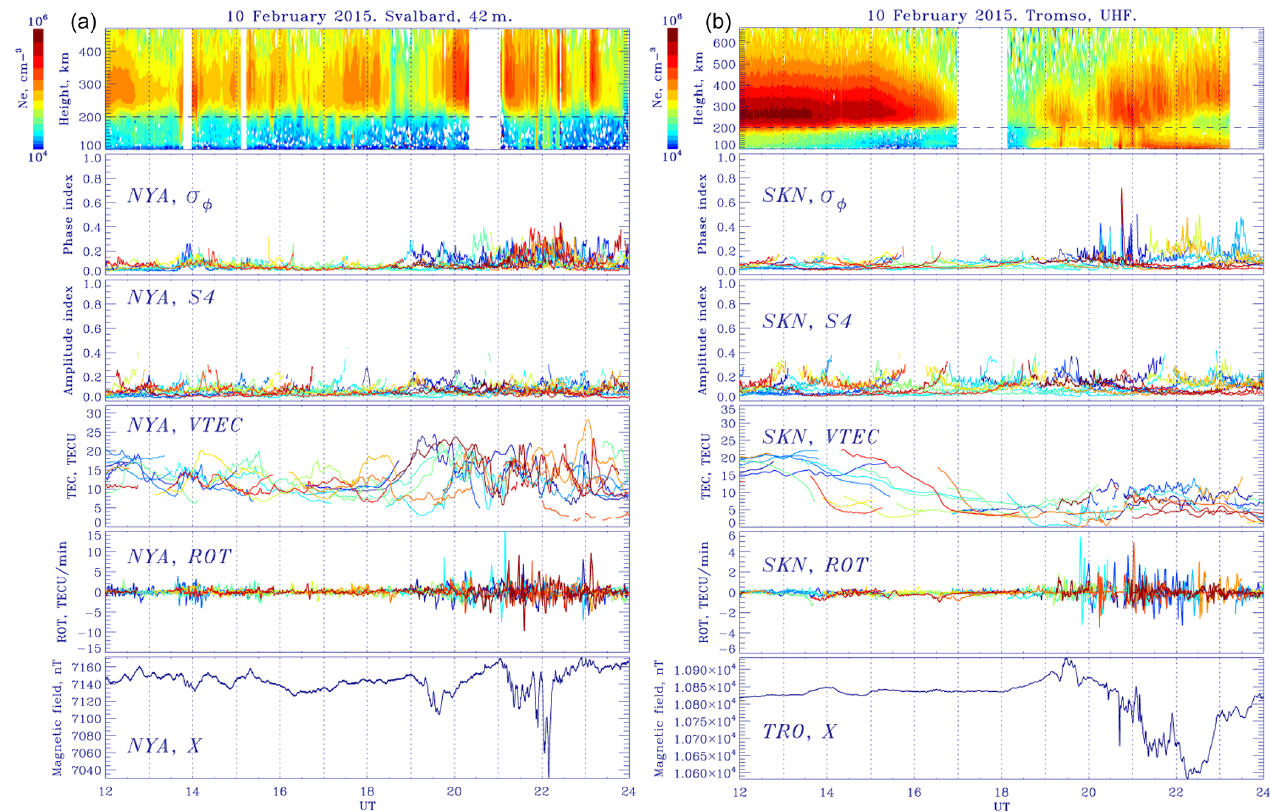
Figure 7. (a) Ionosphere plasma density according to the EISCAT 42m data, phase, amplitude scintillation indexes, TEC and ROT variations according to the GPS receiver at NYA station, and X component of the geomagnetic field at NYA station. (b) Ionosphere plasma density according to the UHF EISCAT data, phase and amplitude scintillation indexes, TEC and ROT variations according to the GPS receiver at SKN station, and X component of the geomagnetic field at TRO station for 10 February 2015.